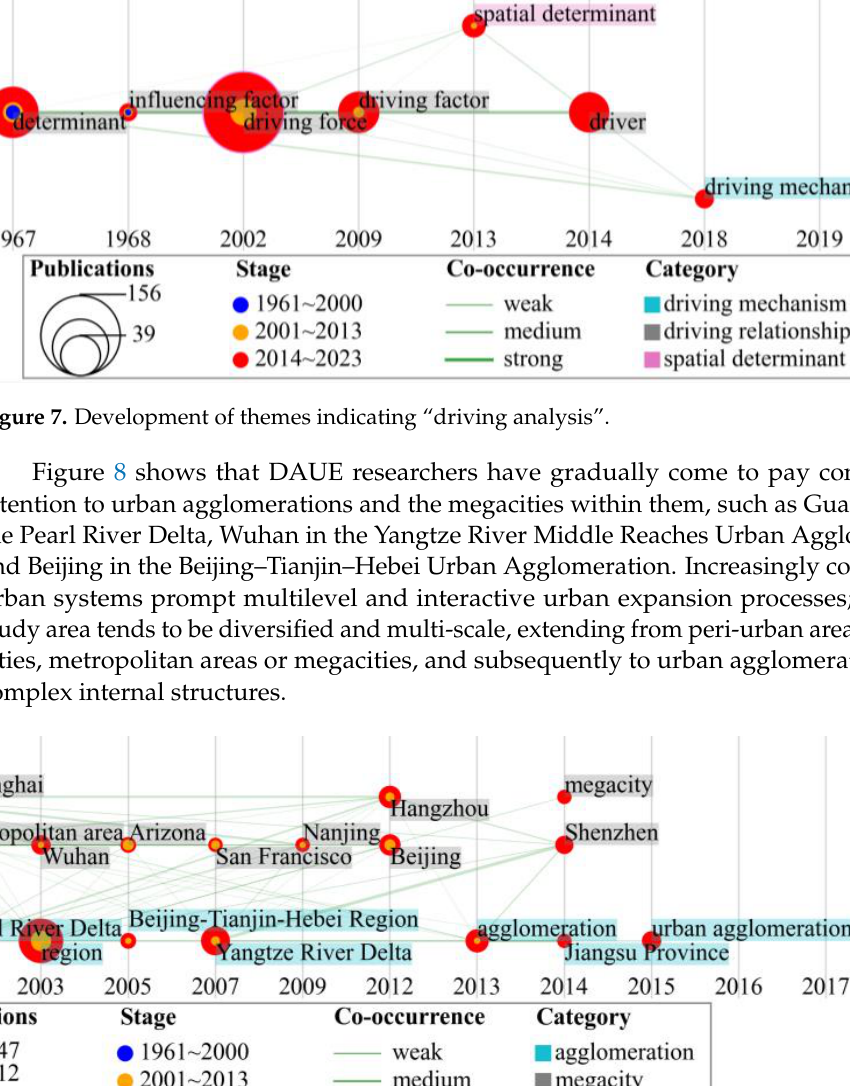
Figure 7. Development of themes indicating “driving analysis”.